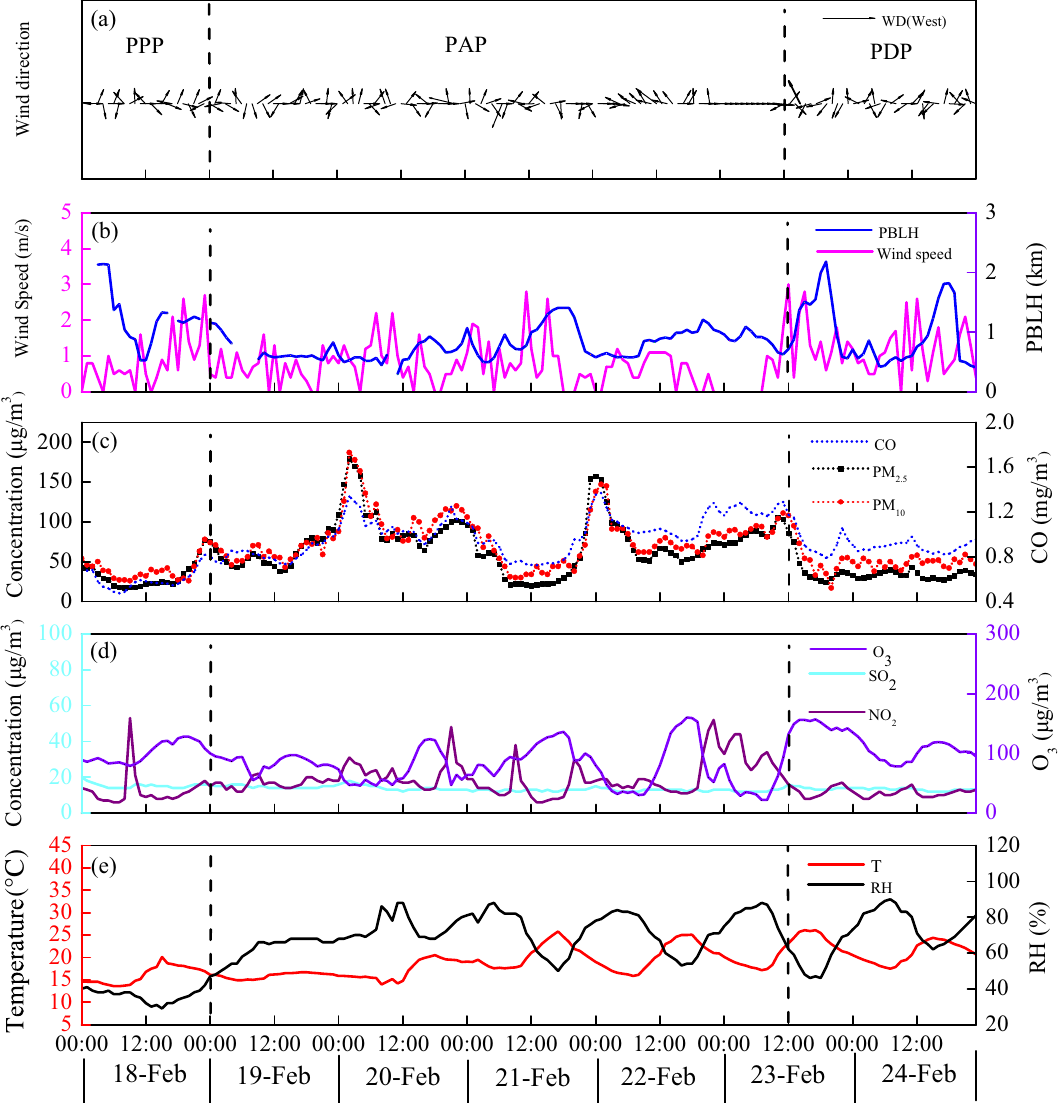
Figure 1. Time series of ( a ) wind direction (WD); ( b ) wind speed (WS) and planetary boundary layer heights (PBLH); ( c ) the main pollutants (PM 10 , PM 2.5 and CO); ( d ) the main gaseous pollutants (O 3 , SO 2 , and NO 2 ); and ( e ) meteorological conditions (temperature and RH) during the study period at the SRAGEP